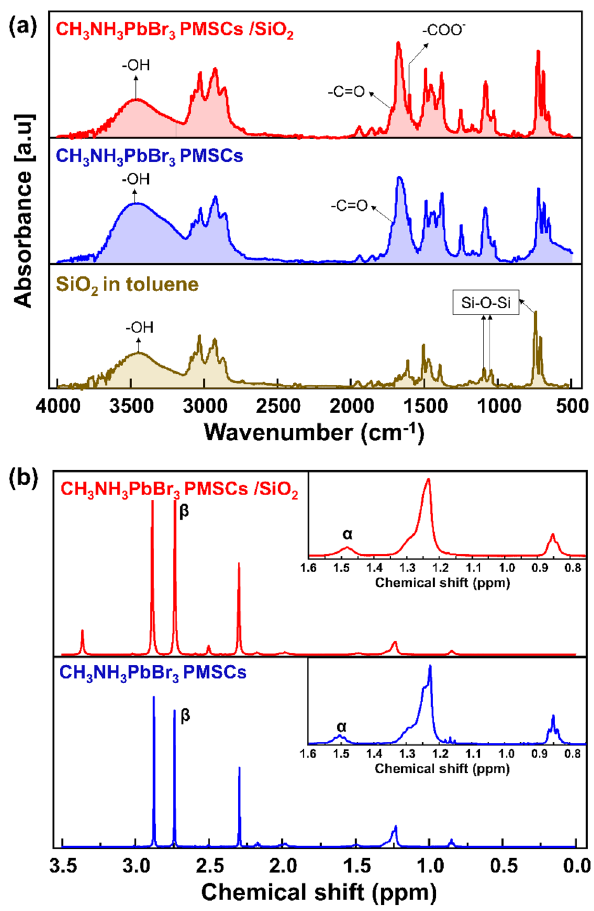
Figure 5. ( a ) FTIR Spectra of the SiO 2 in toluene, CH 3 NH 3 PbBr 3 PMSCs and CH 3 NH 3 PbBr 3 PMSCs/SiO 2 . ( b ) 1 H spectra of the CH 3 NH 3 PbBr 3 PMSCs and CH 3 NH 3 PbBr 3 PMSCs/SiO 2 in deuterated DMSO. The inset figure is the magnification of the 1 H spectra on the chemical shift range 0.8–1.6 ppm showing the broadening peaks for the CH 3 NH 3 PbBr 3 PMSCs/SiO 2